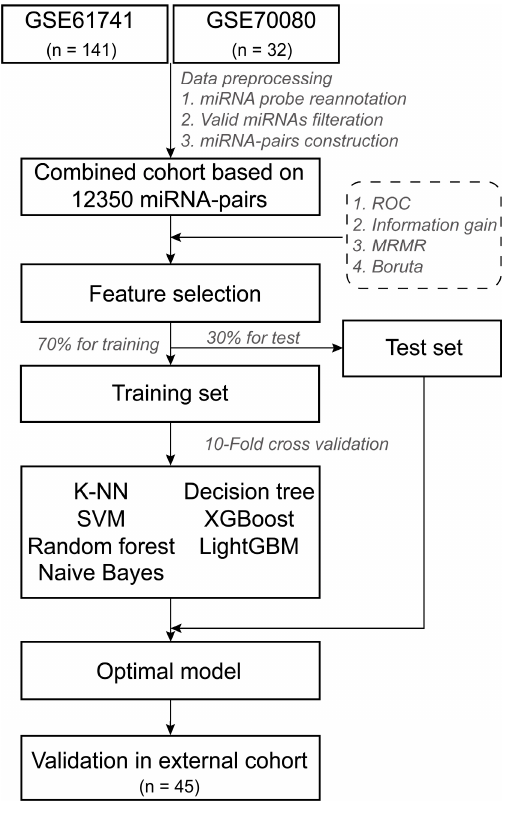
Figure 1. An overall flow chart of the study.